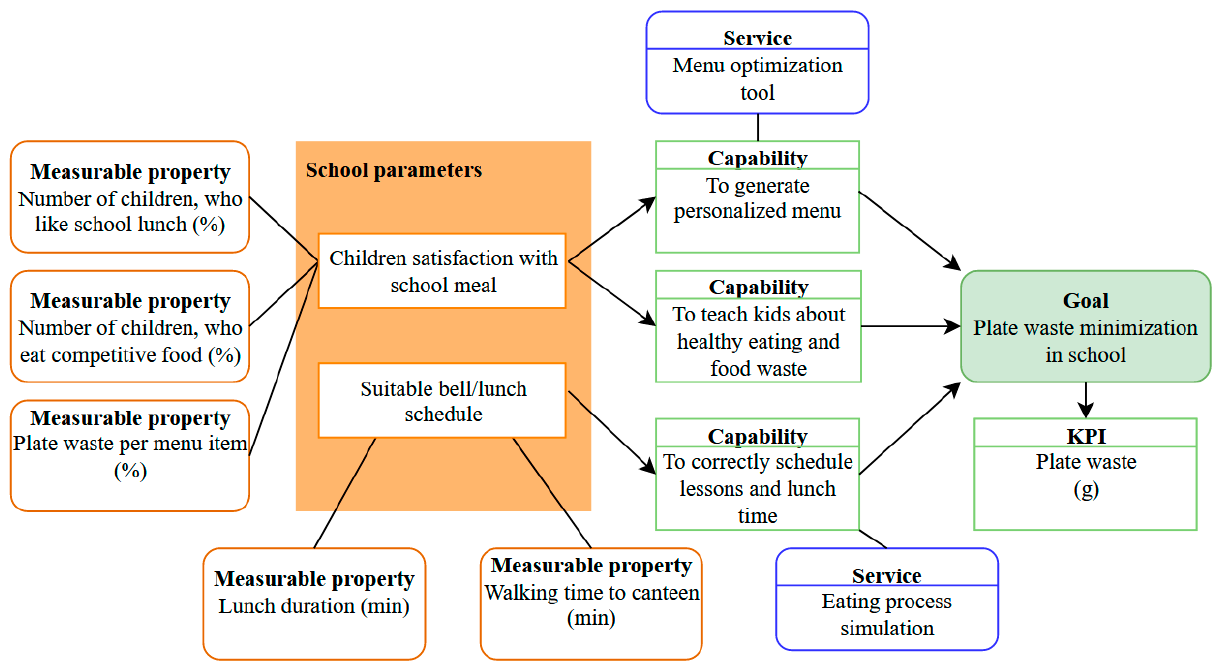
Figure 12. Capability model for effective decision making on food management in schools.